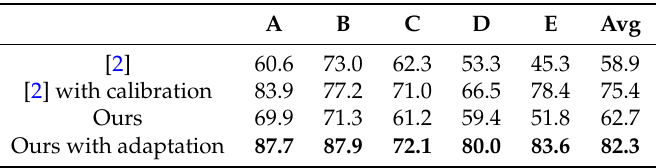
Table 6. Recognition accuracies (%) of the inter-subject evaluation with majority voting over each trial for CSL-HDEMG. Each row corresponds to one method; the columns, denoted by A to E, correspond to 5